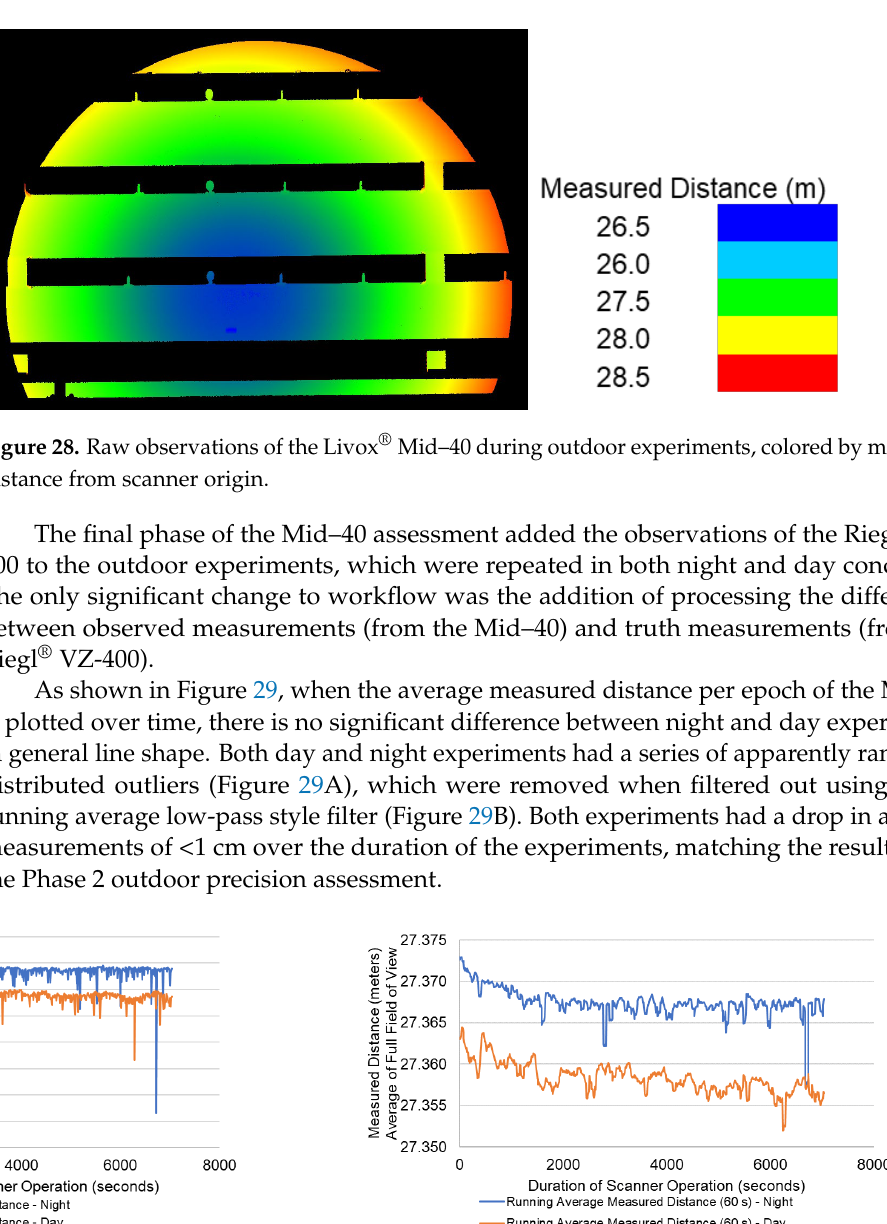
Figure 27. Livox ® Mid–40 indoor point cloud (subset of 10 observation files), colorized by surface point density (points per cm).